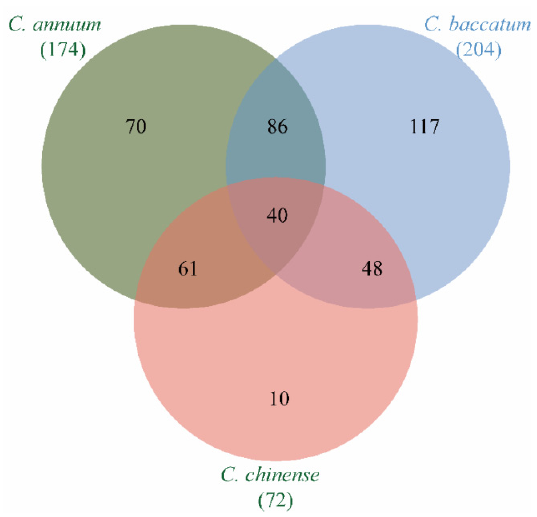
Figure 2. Number of MADS - box orthologs in C. annuum , C. baccatum , and C . chinense .